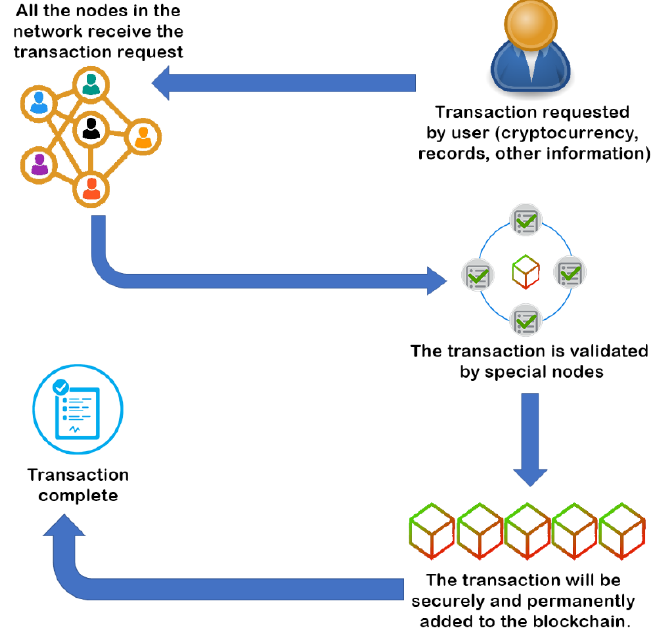
Figure 5. Transaction steps in the Blockchain